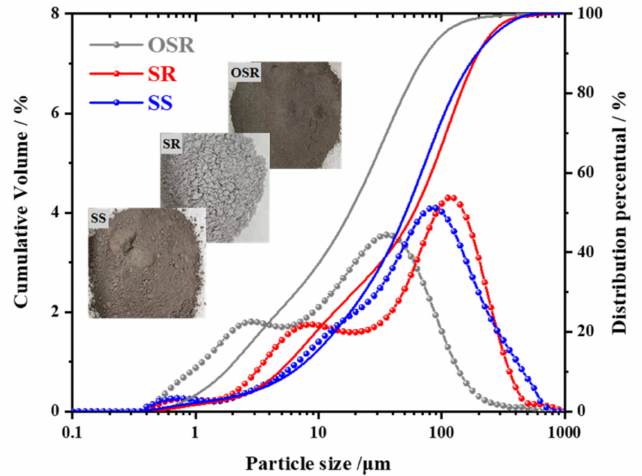
Figure 1. Particle size distribution